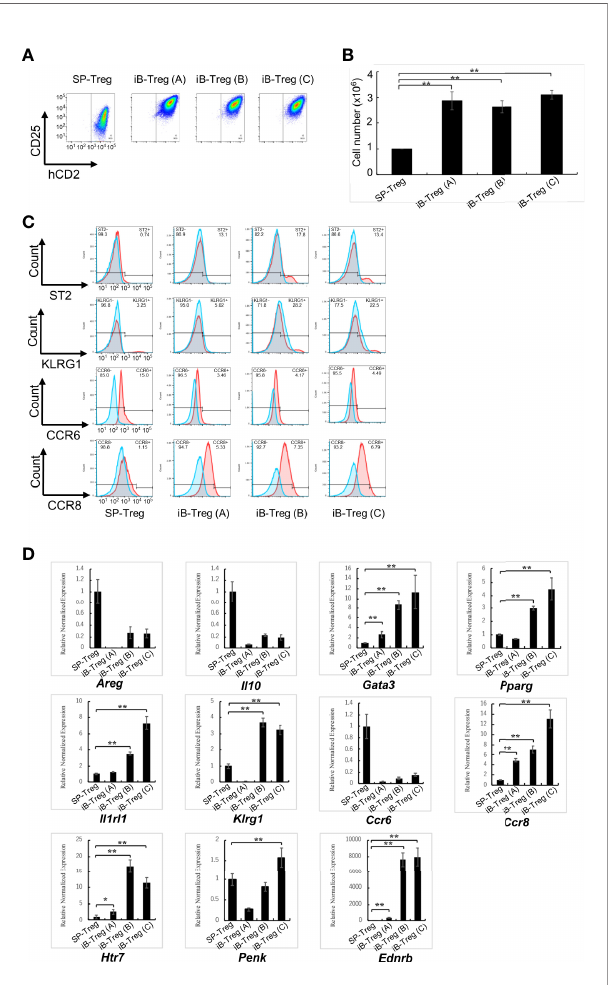
FIGURE 2 | Characterization of in vitro -generated iB-Tregs. SP-Tregs were co-cultured i) with astrocytes in the presence of IL-2 and anti-CD3/CD28 antibodies [iB-Treg (A)]; ii) with astrocytes in the presence of IL-2, IL-33, serotonin and anti-CD3/CD28 antibodies [iB-Treg (B)]; or iii) with astrocytes in the presence of IL-2, IL-33, serotonin, CCL1, CCL20, and anti-CD3/CD28 antibodies [iB-Treg (C)] for 6 days. Blue fi nes were without fi rst antibody, Red lines were with fi rst antibody, and overlapping regions were shown in gray (C) . Then CD25/Foxp3 (hCD2) expression (A) was analyzed using FACS and the number of cells after co-culture was determined (B) . Expression of the indicated tissue Treg markers were analyzed using FACS (C) and RT-qPCR (D) . * P<0.05 ** P<0.01.